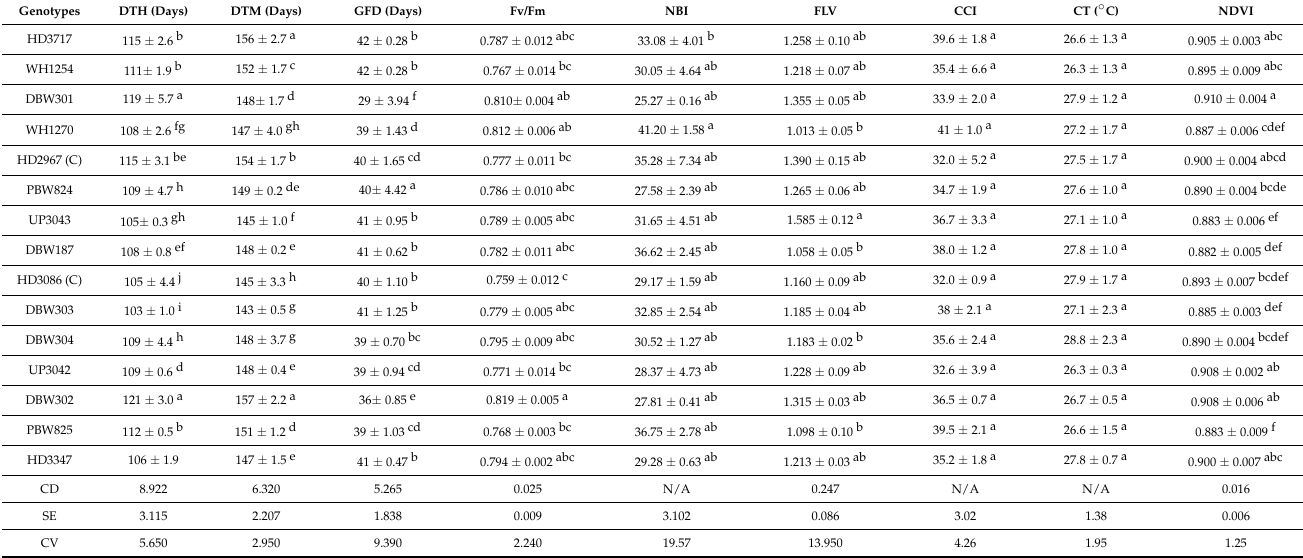
Table 2. Various phenological and physiological traits recorded in Table 2 . Various phenological and physiological traits recorded in HYPT.